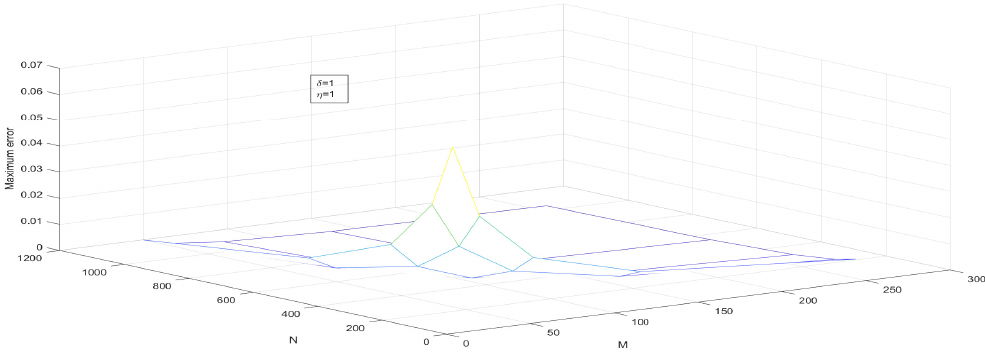
Figure 8. U 2 —the maximum point-wise error of Example 1 for Case 1.